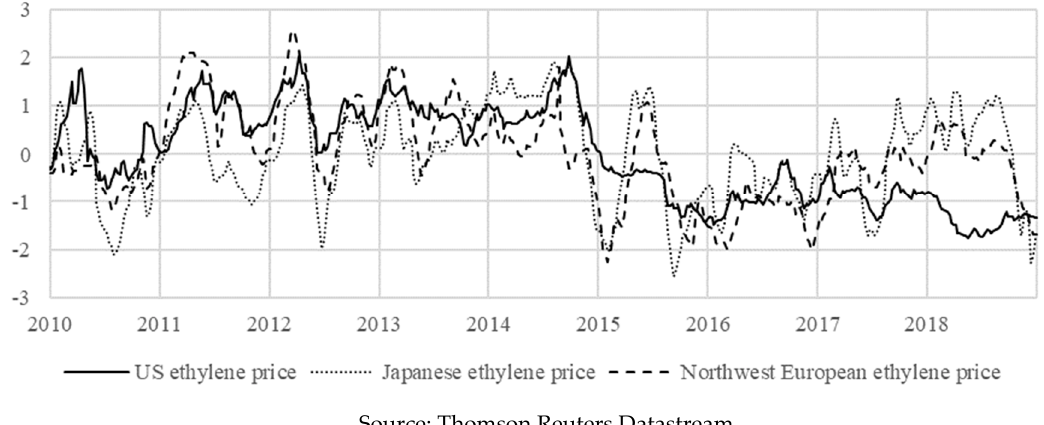
Source: Thomson Reuters Datastream. Figure 2. Standardized trends of ethylene vs. raw material prices ( top ) and regional prices ( bottom ).